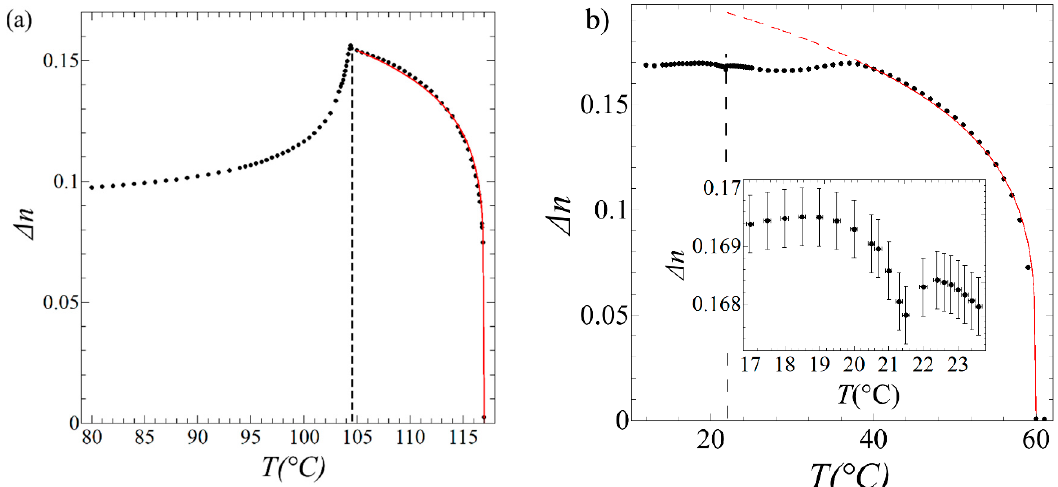
Figure 6. Variation of the birefringence with the temperature for ( a ) CB7CB ( 𝜙 = 100 wt%), ( b ) a mixture with 𝜙 = 43.5 wt%. In both figures, the plain red curve (extended by a dashed curve) is a fit of the birefringence in the nematic phase using Haller formula [49]. The birefringence of the mixture strongly departs from Haller formula much above the N/N TB phase transition, indicating strong pretransitional effects. The black dashed lines indicate the position of the N/N TB phase transition measured by optical microscopy. A small effect is also seen at the transition in the mixture but is of the order of our resolution. Error bars ( 𝛿𝑇 ~0.1 °C and 𝛿Δ𝑛 ~0.001) are smaller than symbols in the main panels.